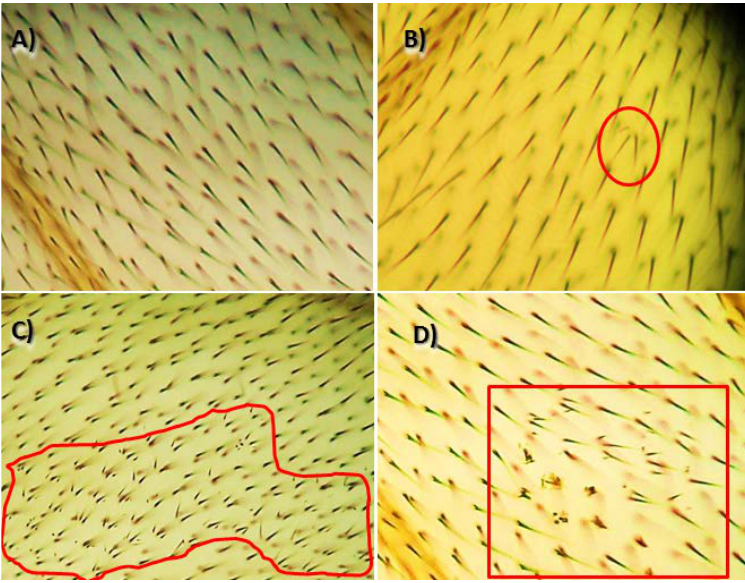
Figure 1. Types of spots found in the Drosophila melanogaster spot wing test: ( A ) wild phenotype (normal trichomes); ( B ) simple mwh spot; ( C ) large mwh spot; and ( D ) twin spot.